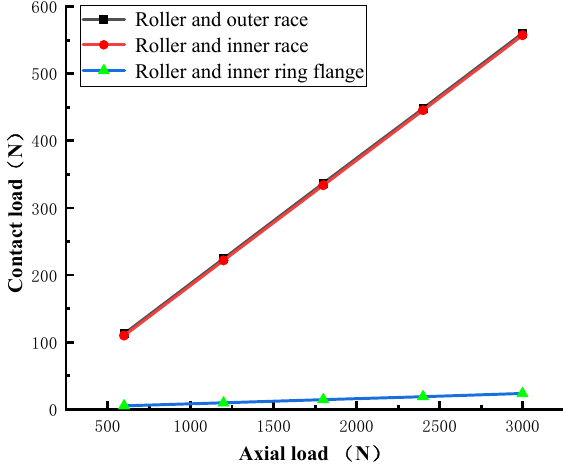
Figure 13. Influence of axial load.